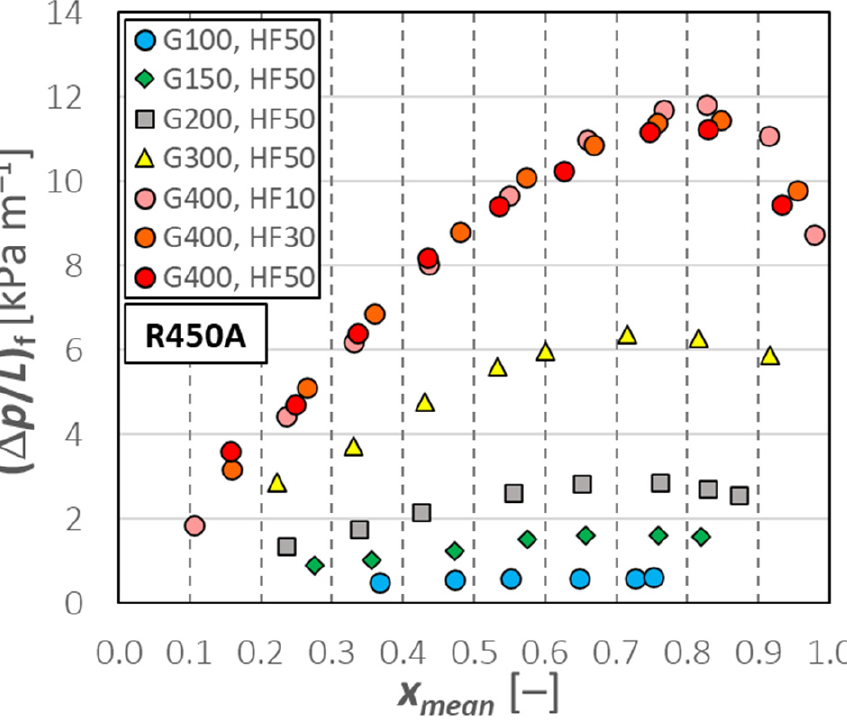
Figure 6. Frictional pressure gradient for R450A vs. mean vapor quality at t sat = 30 °C. G100 = 100 kg m − 2 s − 1 , G150 = 150 kg m − 2 s − 1 , G200 = 200 kg m − 2 s − 1 , G300 = 300 kg m − 2 s − 1 , and G400 = 400 kg m − 2 s − 1 . HF10 = 10 kW m − 2 , HF30 = 30 kW m − 2 , and HF50 = 50 kW m − 2 .